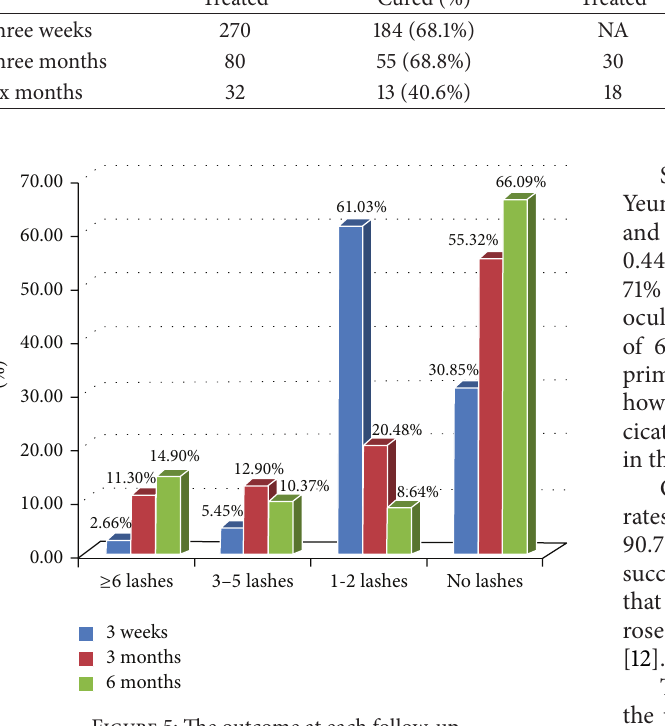
lash bearing area. Ten patients (15 lids, i.e., 13.4% of failed cases) deferred surgical